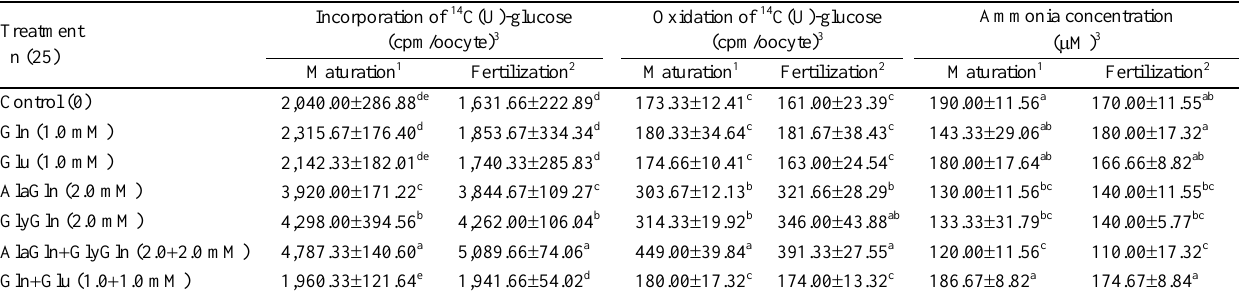
Table 2. The rates of incorporation and oxidation of 14 C(U)-glucose and the accumulation of ammonia upon treatment with glutamine (Gln), glutamic acid (Glu), L-alayl-L-glutamine (AlaGln), L-glycyl-L-glutamine (GlyGln) and their combinations on the maturation and fertilization of porcine oocytes